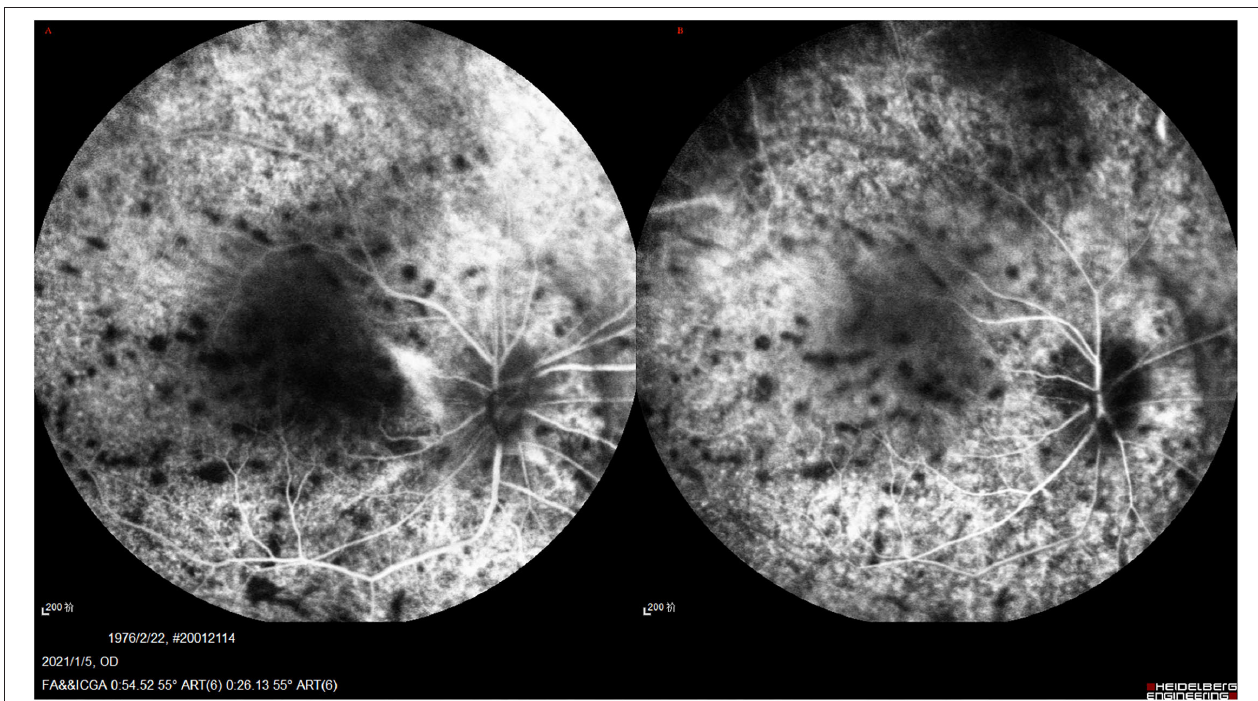
FIGURE 6 | (A,B) UES in type 2. FA/ICGA (Spectralis; Heidelberg Engineering, Inc) findings showed diffused patchy hyperfuluorescence and leopard-spot sign, which were almost similarly observed in type 1, without dye leakage in any eye.